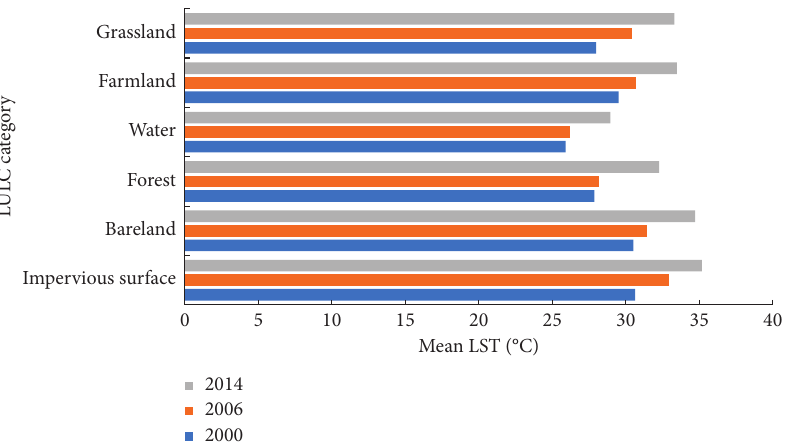
Figure 5: Mean LST values for the LULC categories from 2000 to